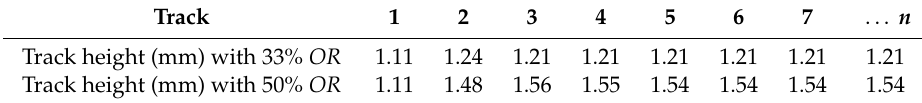
Figure 10. Multi-track, single-layer deposition for given OR ; theoretical profiles. Table 6. Prediction of track height for a given layer as a function of the OR .